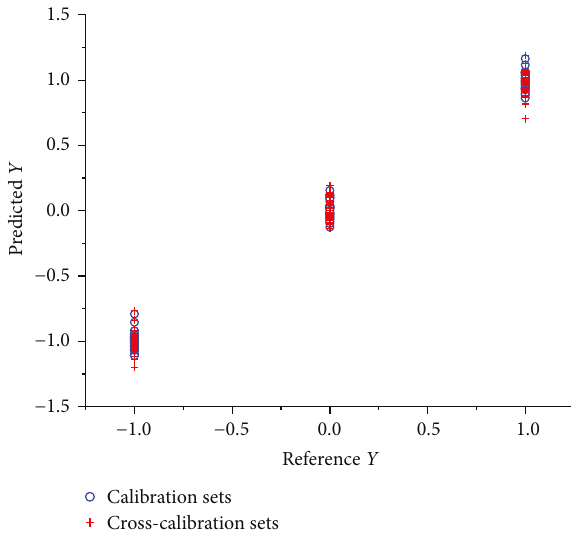
Figure 6: PLS-DA model plot of the predicted Y values and reference Y values for calibration sets.